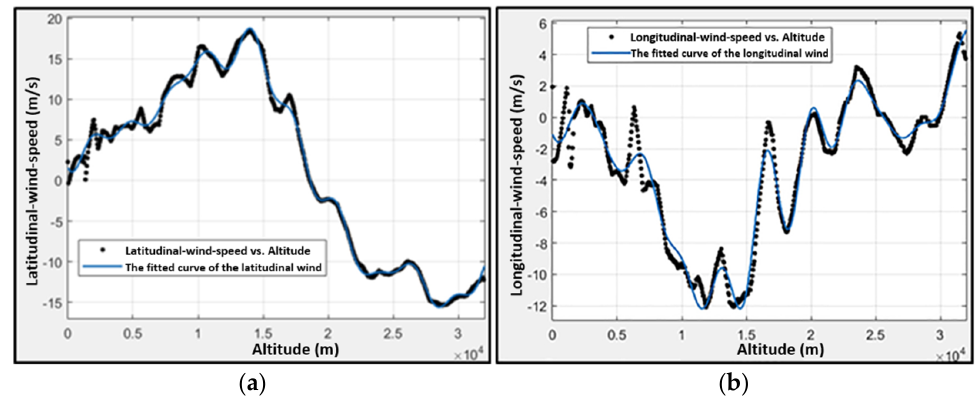
Figure 4. Discrete wind data and the corresponding fitted curve. ( a ) shows the discrete latitudinal wind data and the fitted curve of the latitudinal wind. ( b ) shows the discrete longitudinal wind data and the fitted curve of the longitudinal wind.